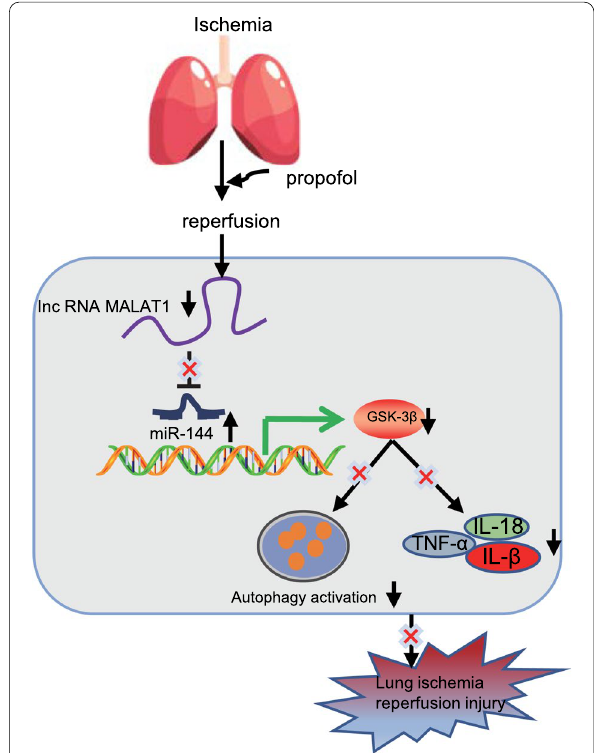
Fig. 8 The molecular scheme showing the impacts of Propofol involving the MALAT1/miR‑144/GSK3β axis on lung I/R